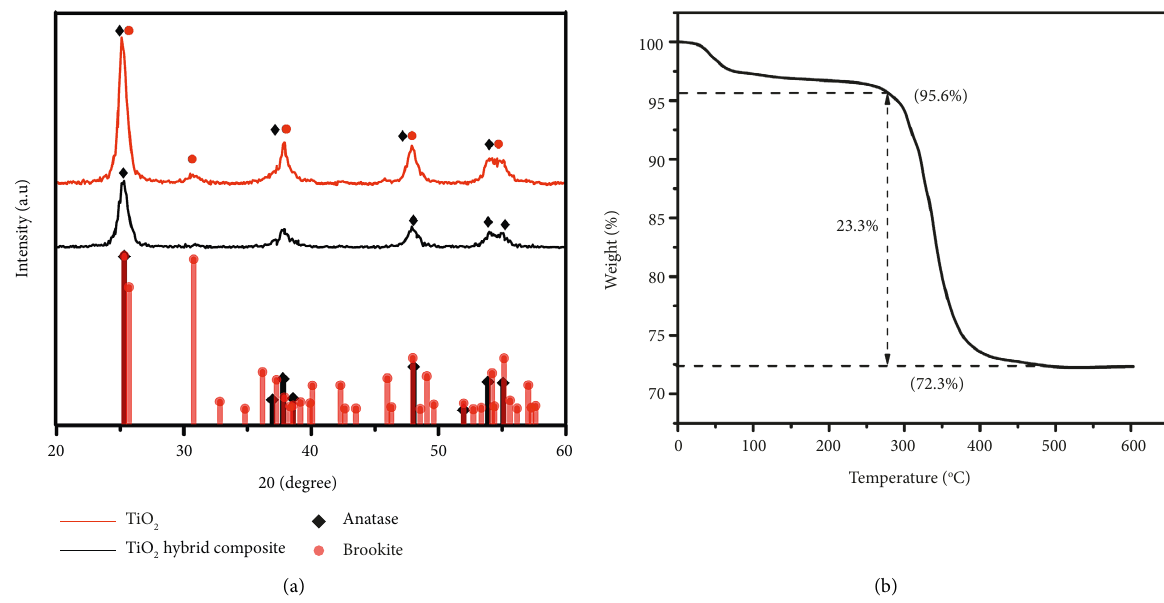
Figure 1: (a) XRD profiles of pure TiO 2 and bio-inspired C/N/TiO 2 hybrid composite. (b) Thermogravimetric analysis (TGA) of bio- inspired TiO 2 hybrid